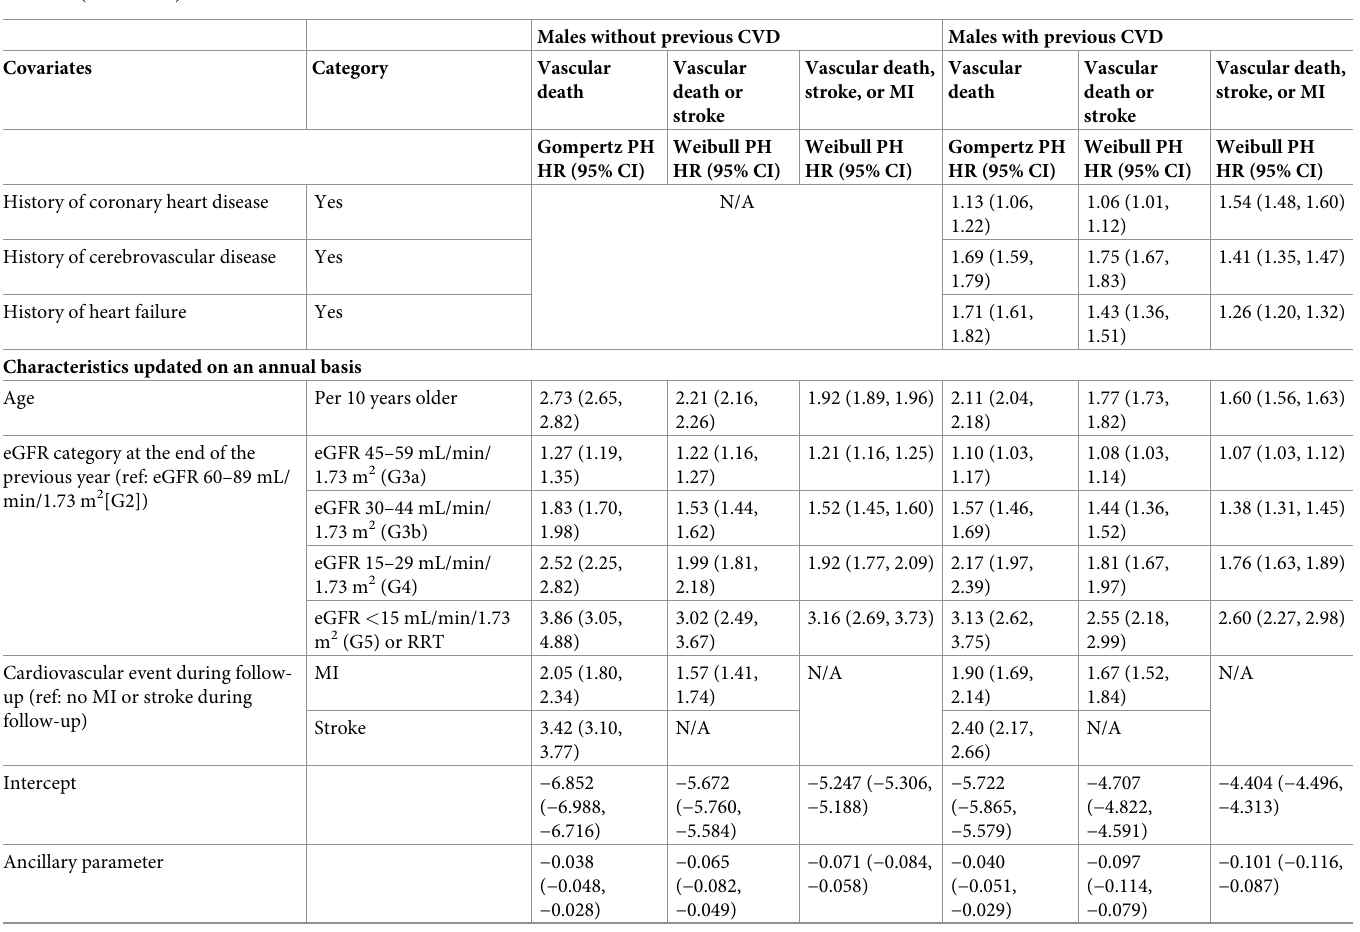
tial across all patient categories, with younger patients with previous CVD deriving largest benefits. Among patients aged 60 to 69 without previous CVD, the use of these treatments at